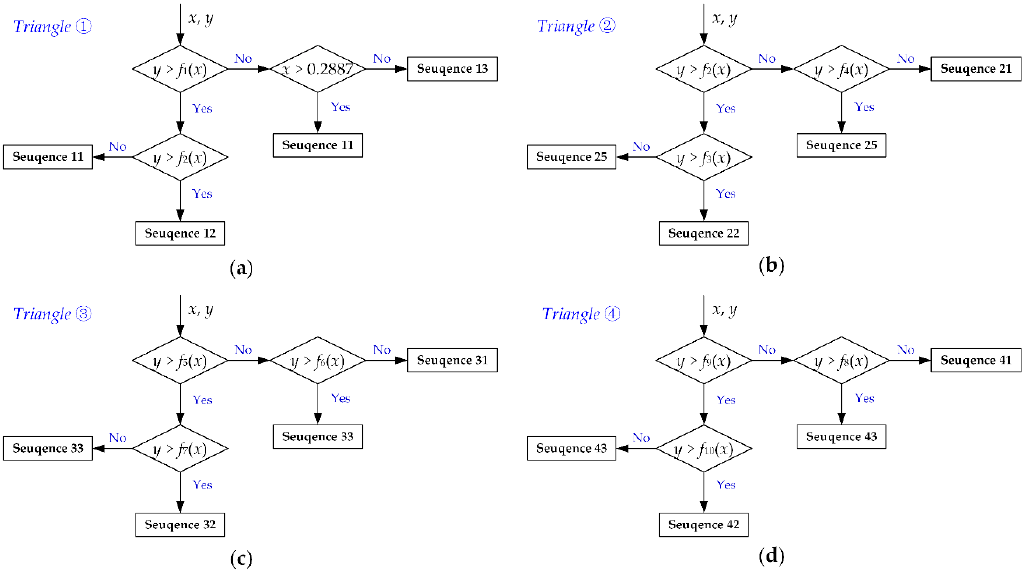
Figure 7. The flowchart to find out the spatial sub-region and switching sequence of the proposed modulation strategy in Sector Z 1 : (a) Triangle ① ; (b) Triangle ② ; (c) Triangle ③ ; (d) Triangle ④ .